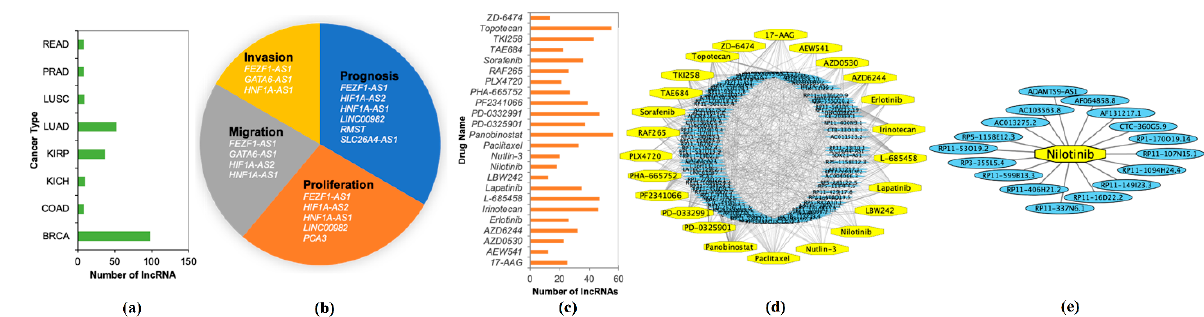
Figure 6. Validation of Identified lncRNAs. ( a ) Number of known lncRNAs derived by mrCAE related to different cancer types found in [20–23]; ( b ) mrCAE derived lncRNAs related to different cancer hallmarks [24]; ( c ) number of lncRNAs, related to different cancer drugs [19]; ( d ) drug–lncRNA networks for all 24 drugs; ( e ) an example lncRNA–drug network for nilotinib, which is used to treat certain blood cancers associated with 18 different lncRNAs. ( d , e ) were generated using Cytoscape.